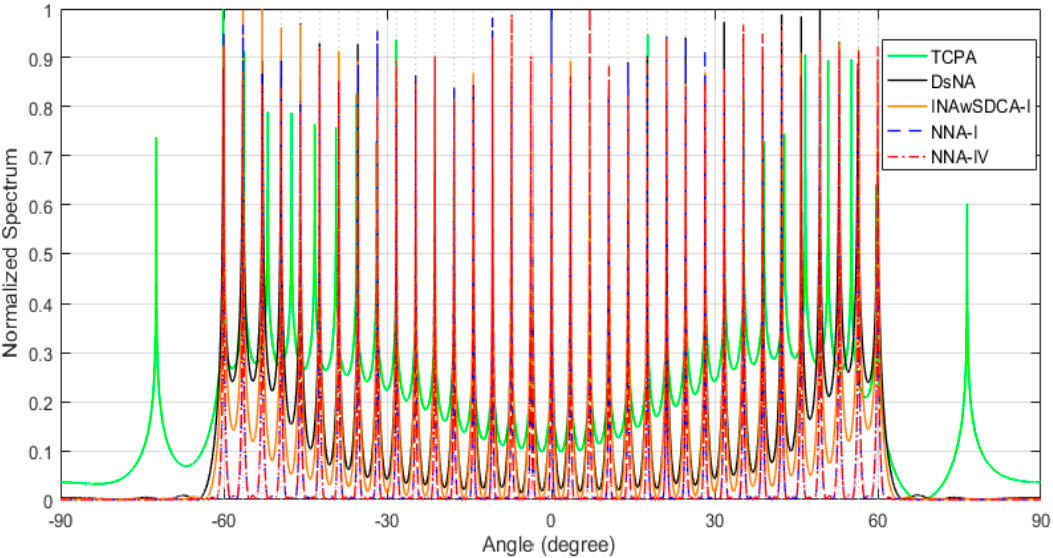
Figure 4. The normalized spectra of thinned coprime array (TCPA), diff-sum nested array (DsNA), improved NA with SDCA I (INAwSDCA-I), NNA-I, and NNA-IV.